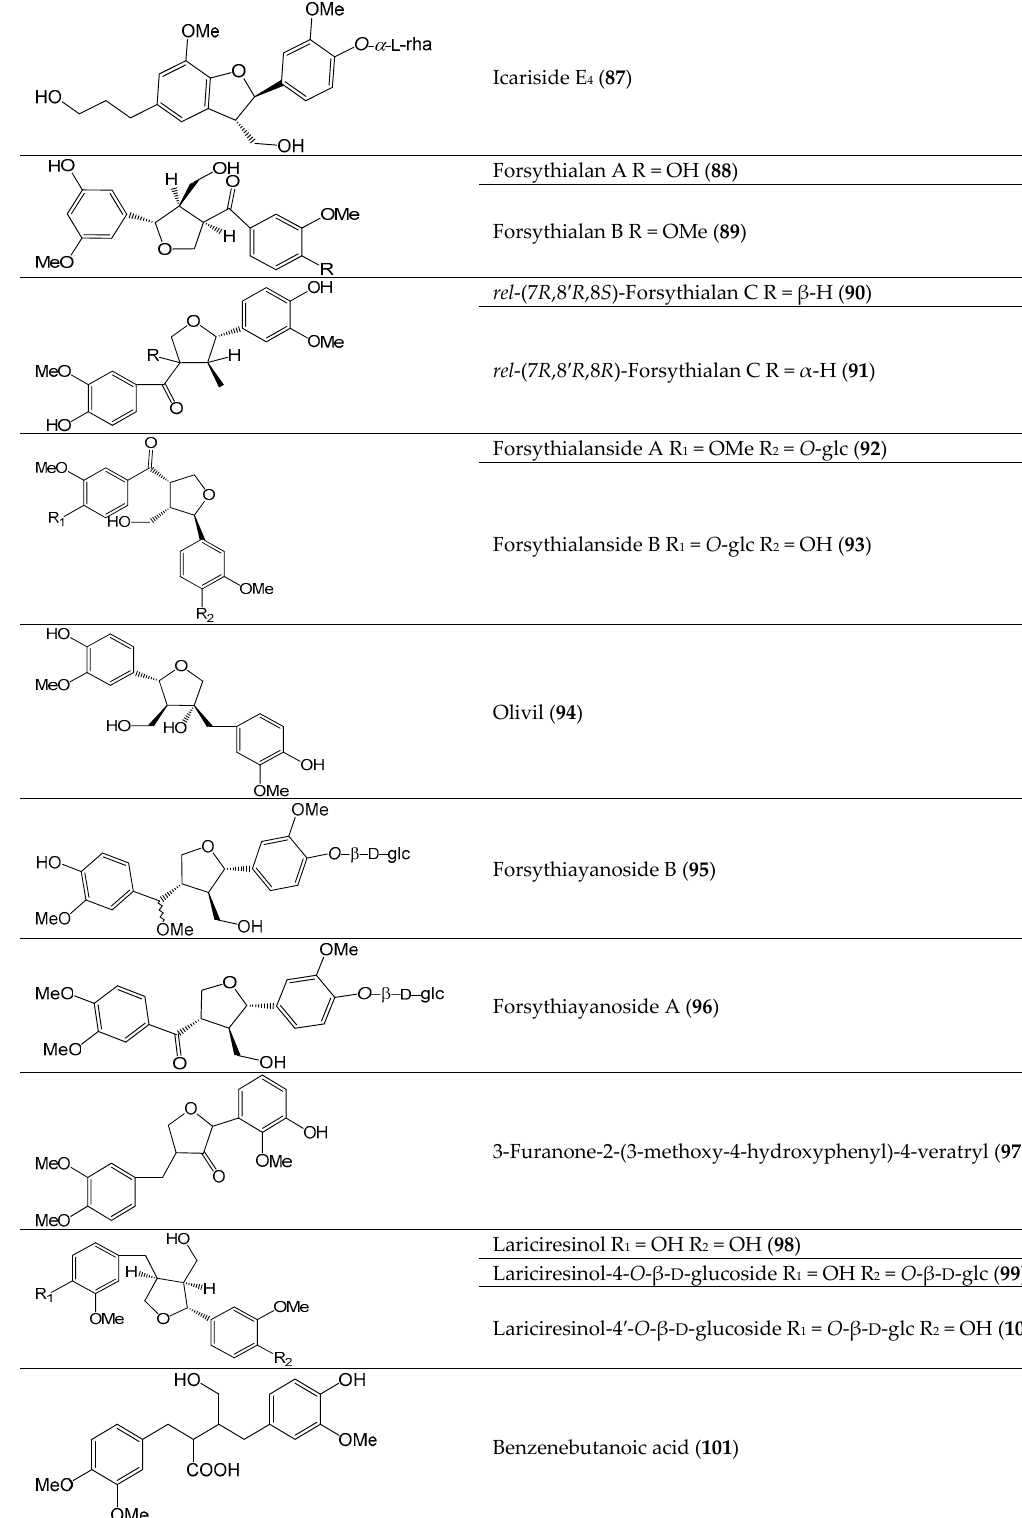
Figure 2. Chemical structures of lignans in Forsythiae Fructus.